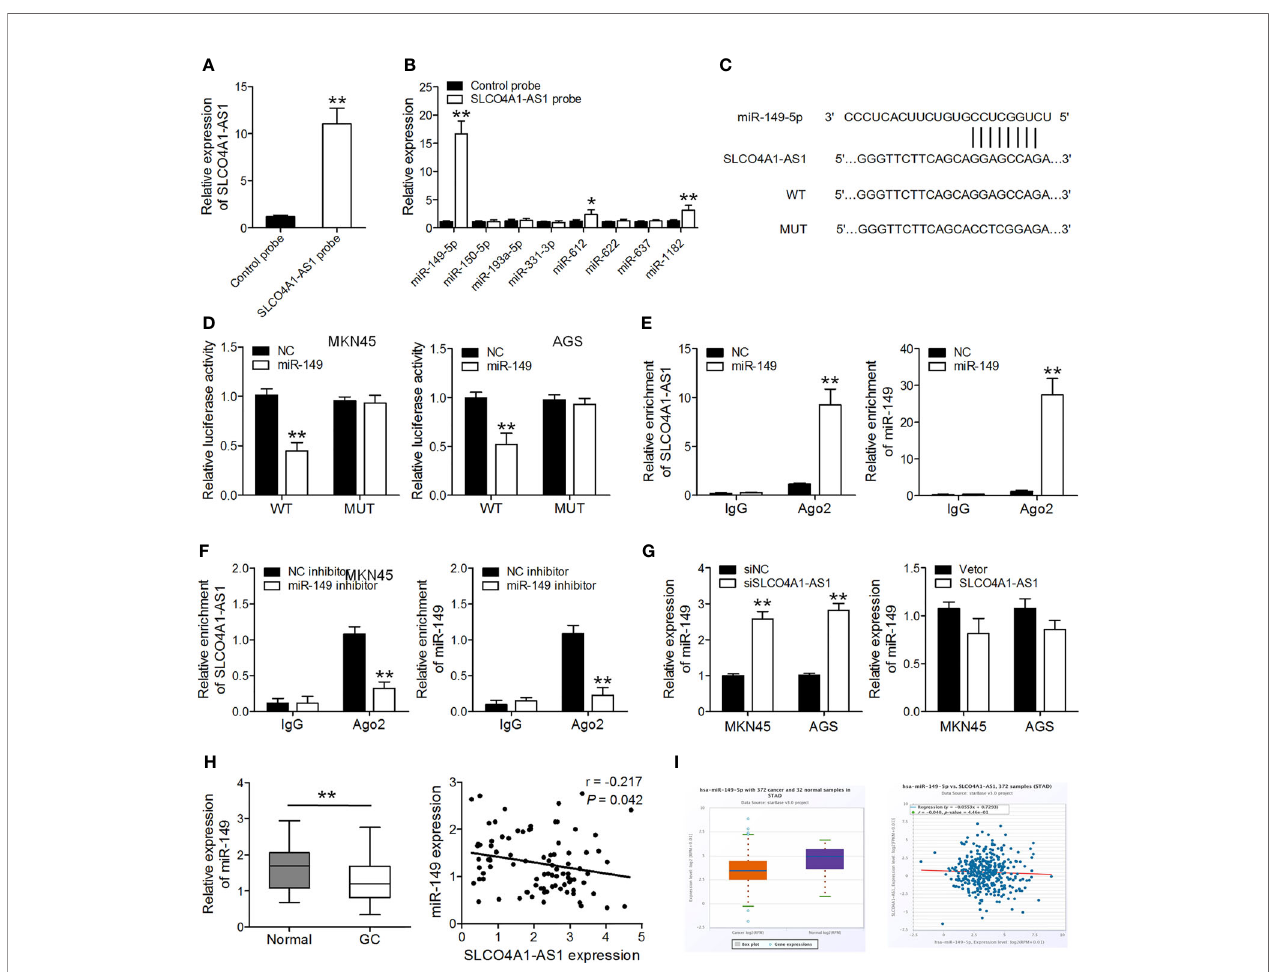
FIGURE 2 | SLCO4A1-AS1 serves as a sponge for miR-149 in gastric cancer (GC). (A) SLCO4A1-AS1 in MKN45 cell lysis was pulled down and enriched with SLCO4A1-AS1 speci fi c probe and then assessed by RT-qPCR. (B) miRNAs in MKN45 cell lysis was pulled down and enriched with SLCO4A1-AS1 speci fi c probe and then assessed by RT-qPCR. (C) Sequence alignment of SLCO4A1-AS1 with wild-type (WT) versus mutant (MUT) potential miR-149 targeting sites. (D) Luciferase reporter assay was performed to measure the luciferase activities. (E, F) The association among SLCO4A1-AS1, miR-149, and Ago2 was determined using RIP assays in MKN45 cells transfected with miR-149 mimic or inhibitor. (G) RT-qPCR analysis of miR-149 level in MKN45 and AGS cells transfected with siSLCO4A1-AS1 or SLCO4A1-AS1 overexpression vector. (H) RT-qPCR analysis of miR-149 levels in GC and normal samples; correlation analysis of miR-149 and SLCO4A1-AS1 expression by Pearson ’ s correlation. (I) The expression of miR-149 in 372 GC and 32 normal samples in the ENCORI database; correlation analysis of miR-149 and SLCO4A1-AS1 expression is also shown. * P < 0.05, ** P <